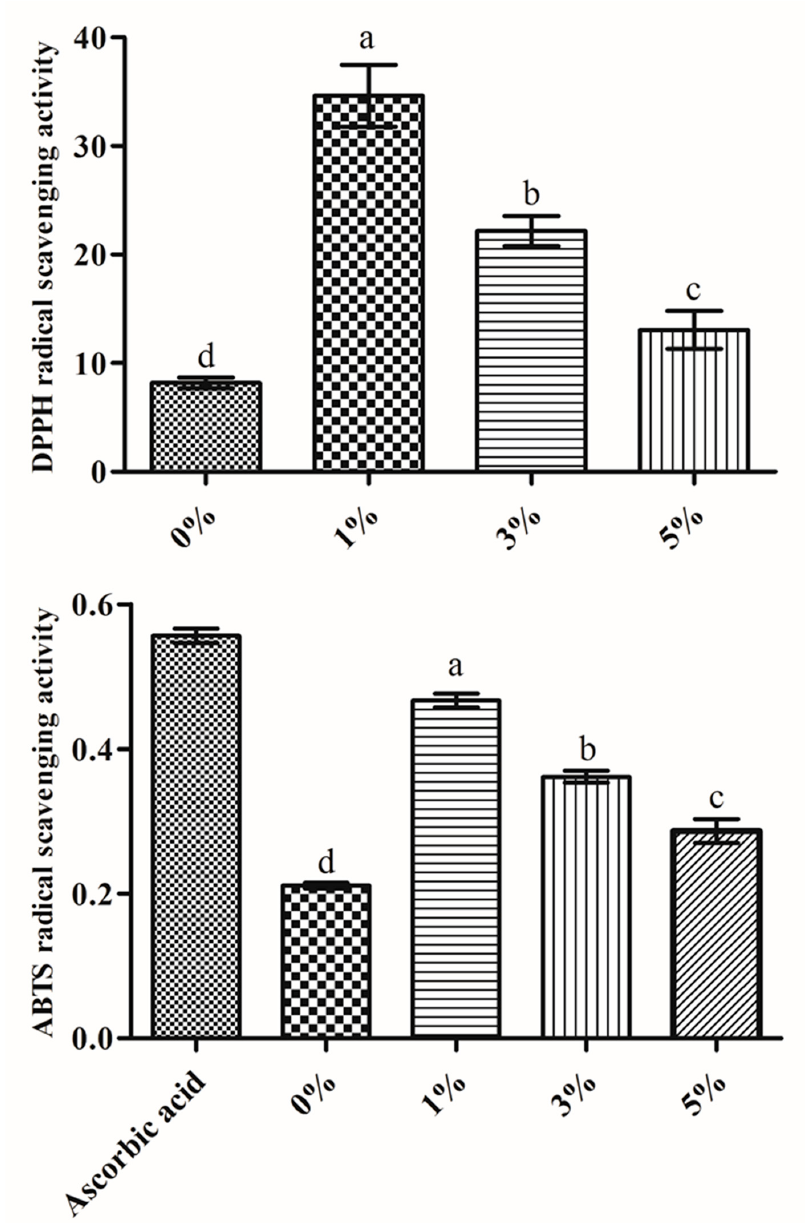
Figure 2. 2,2-diphenyl-1-picrylhydrazyl (DPPH) radical-scavenging and 2,2 ′ -azino-bis (3-ethylbenzthiazoline-6-sulfonic acid) (ABTS) radical scavenging activity of non-fermented and fermented soybean using different concentrations (1%, 3%, and 5%) of the B. amyloliquefaciens RWL-1. The letters a, b, c, and d indicate significant differences ( P ≤ 0.05) by DMRT.